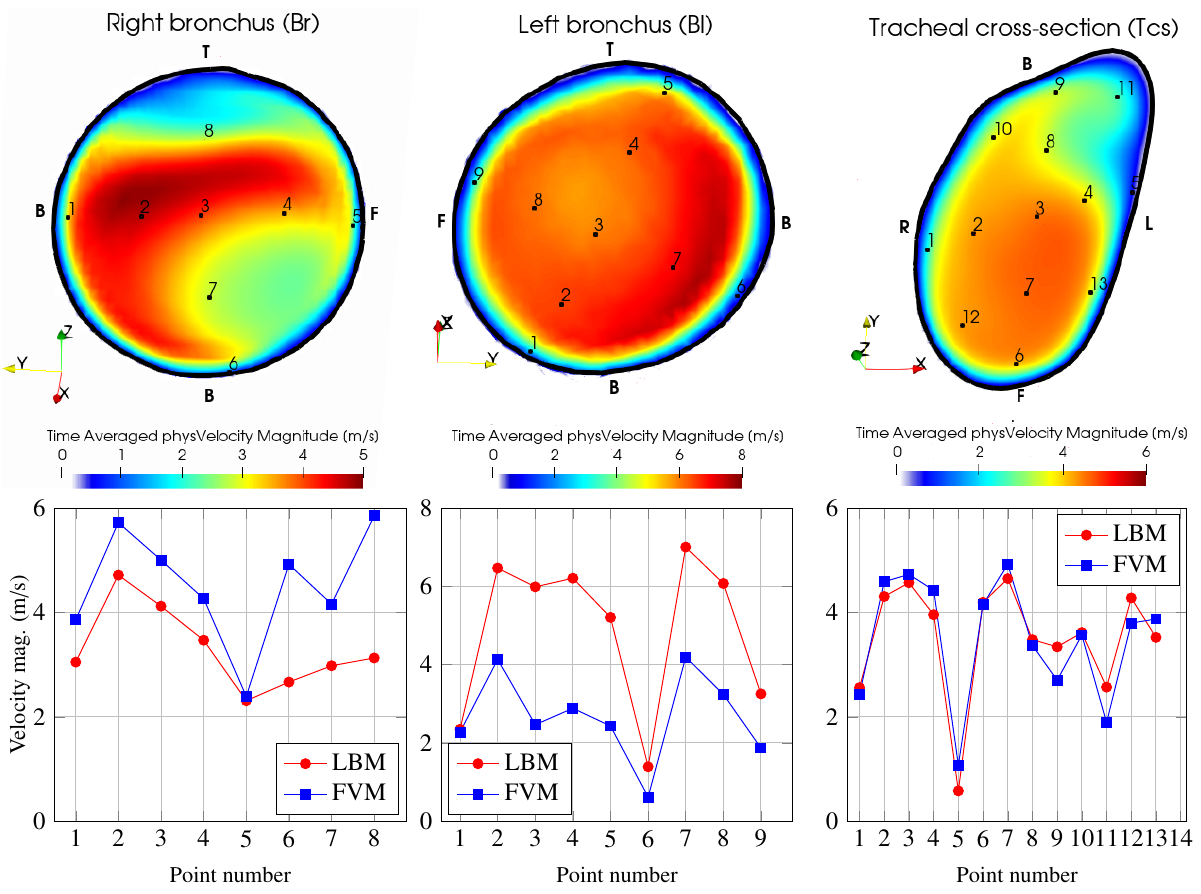
Fig. 5. Comparison of velocity fields at the investigated positions in the tracheal cross section and in the right and left bronchus.